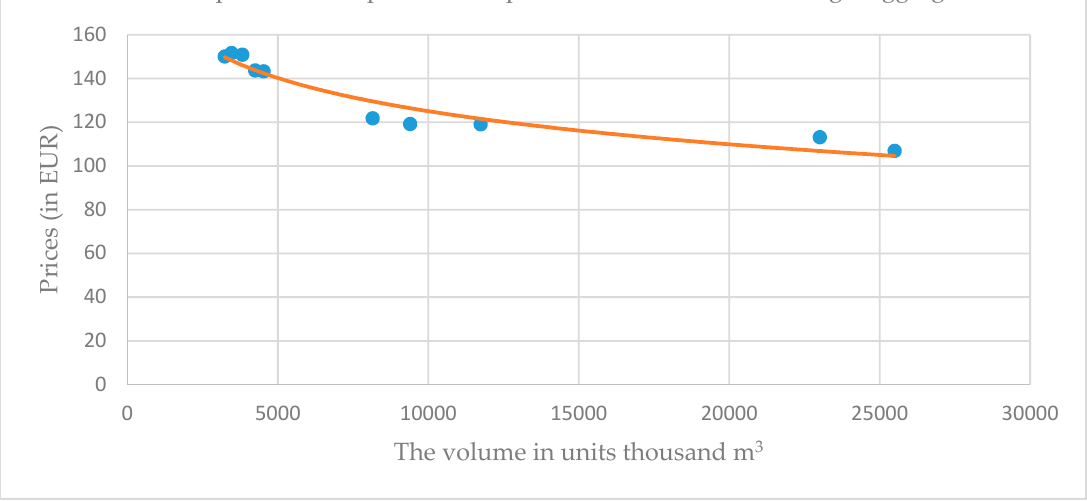
Figure 4. The dependence of the price of spruce wood on the volume of random logging—exponential model. Source: own calculations; exponential regression model: y = 18058x − 0.192 ; R² = 0.9343.